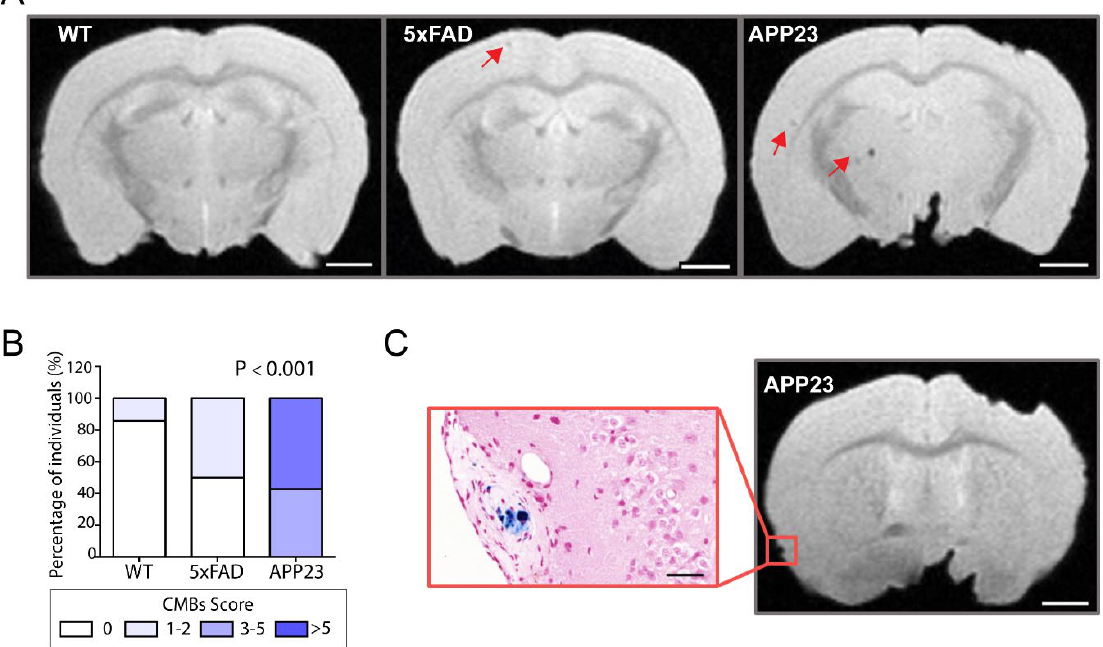
Figure 5. MRI detection of CAA-related cerebral microbleeds in 5xFAD and APP23 mice. ( A ) Representative T2* magnetic resonance images (MRI) of cerebral microbleeds (cMBs) in 20-month-old male WT, 5xFAD, and APP23 mice. cMBs are indicated with red arrows. Scale bar indicates 2 mm. ( B ) Distribution of cMBs in WT, 5xFAD, and APP23 mice, according to the percentage of individuals affected. N = 4–7/group. ( C ) Comparison of cMBs in APP23 mice T2* sequences and Prussian blue staining showing iron hemosiderin deposits. Scale bar indicates 2 mm and 40 μm.